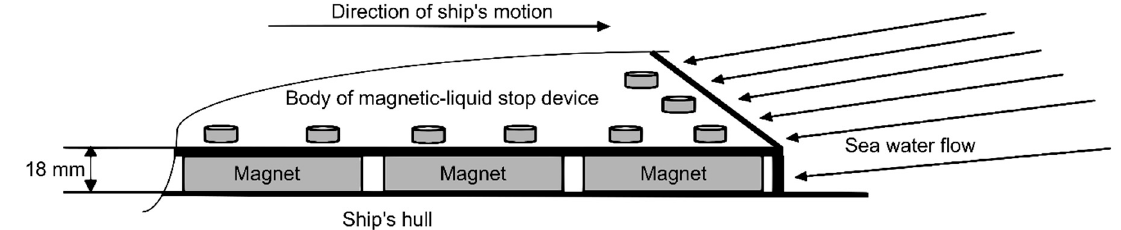
Figure 7. Water flow concept when a device is attached to the ship’s hull.